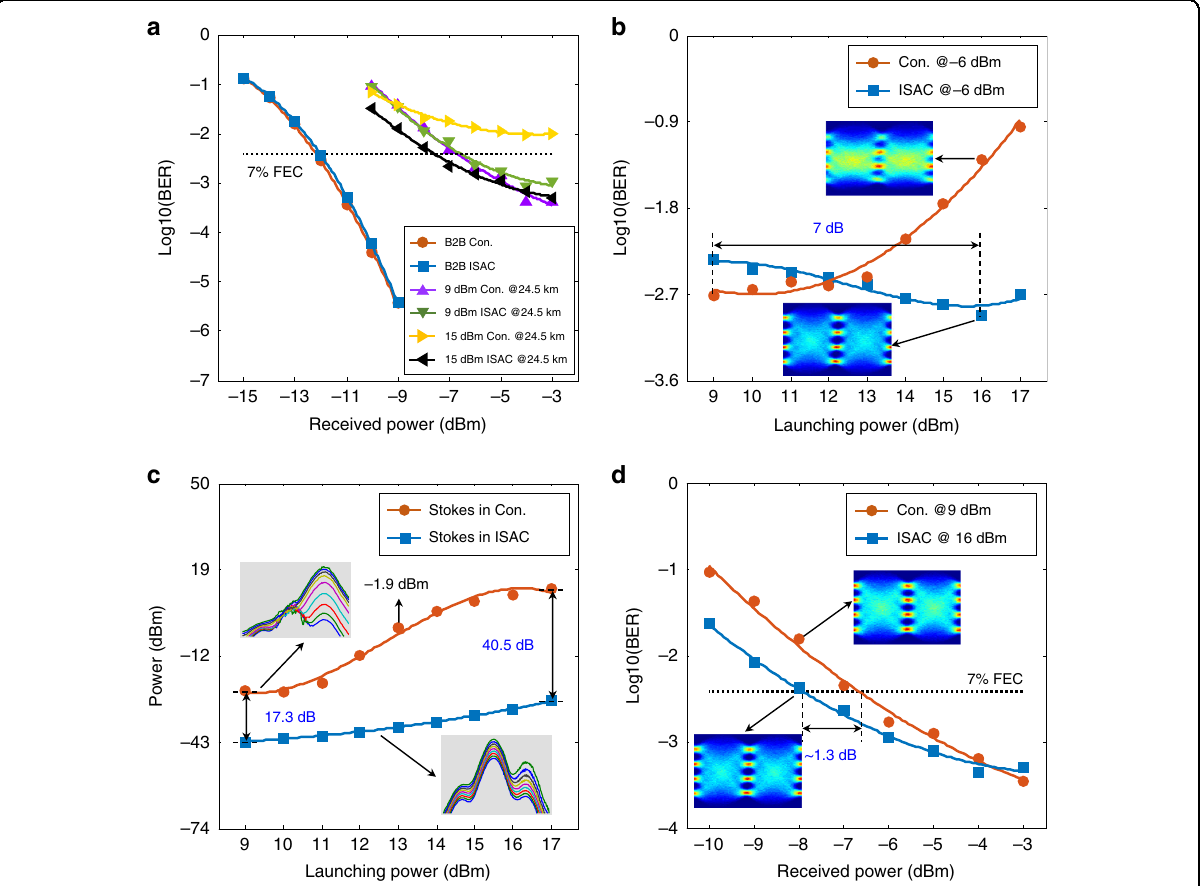
Fig. 3 Comparison of the BER performance in the conventional PAM4 signal transmission (Con.) and integrated sensing and communication in optical fi bre (ISAC). a BER performance of 56 Gbit/s PAM4 signal in B2B and 24.5 km fi bre transmission. The results for 24.5 km fi bre transmission using 9 dBm and 15 dBm launching power are shown here. b BER performance evolution of 56 Gbit/s PAM4 signal as the launching power increases. The received power was fi xed at − 6 dBm in all tests. c Power evolution of the backwards Stokes light as the launching power increases. d BER performance of 56 Gbit/s PAM4 signal in Con. (9 dBm launching power) and ISAC (16 dBm launching power) for different received